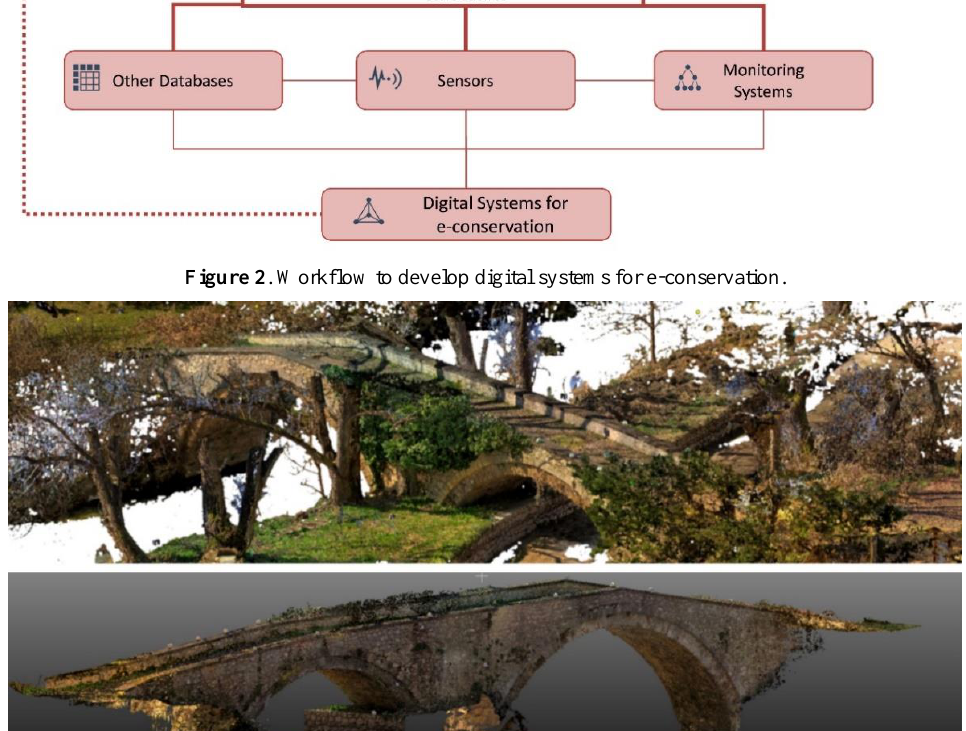
Figure 3. TLS point